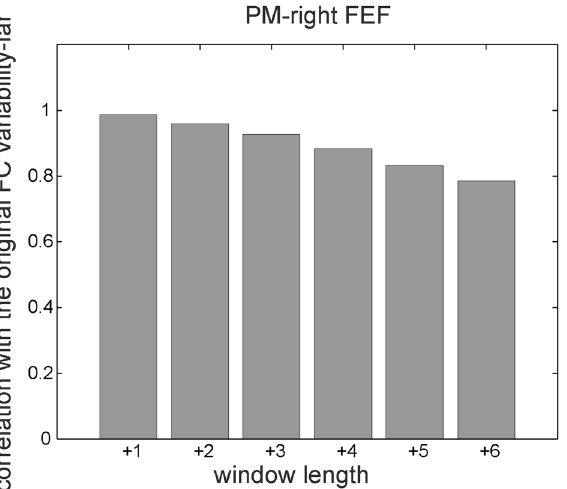
Figure 6. Correlation between FC variability and the one computed increasing the window length for PM-right FEF